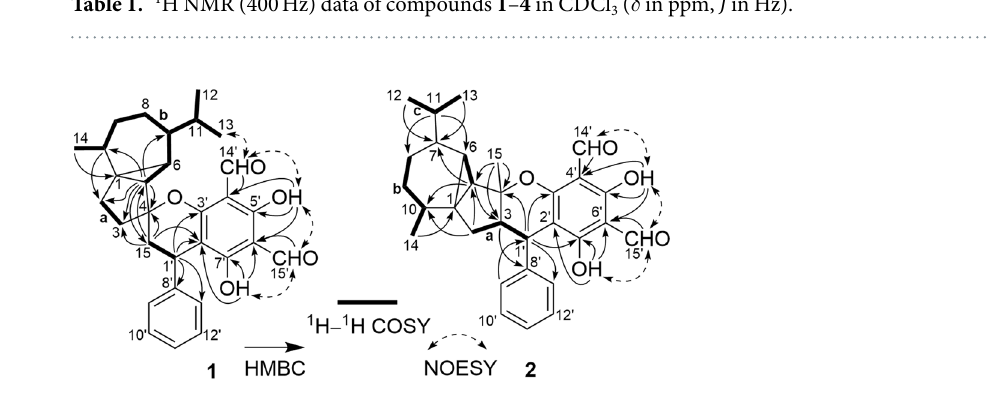
were replaced by a oxygenated methine ( δ C 85.5, C-2) and a tetra-subsitituted double bond ( δ C 138.2 and 136.0, C-1 and C-10) in 3 . This indicated that the oxygen bridge started from C-1 in 16 was migrated to C-2 with the formation of Δ 1(10) in 3 , which was further confirmed by the HMBC correlations (Fig. 6) from H 3 -14 to C-1, C-9, and C-10 and from H-2 to C-3 ′ , C-1, and C-10. The relative configuration of 3 was assigned by the NOE analysis (Fig. 7). The NOE correlations of H-3b/H-2, H-6, and H 3 -15, H-3a/H-2, H 3 -15, and H-13 ′ (9 ′ ), H 3 -12/H-6 and H-7, and H 3 -15/H-9 ′ (13 ′ ) indicated that H-2, H-6, H-7, CH 3 -12, CH 3 -15, the phenyl group, and the C-2–C- 3–C-4 bridge were cofacial and were arbitrarily assigned β -orientations. Thus, the α -orientation of H-5, H 3 -13, and H-1 ′ was deduced by the NOE correlations of H-5/H 3 -13 and H-1 ′ . The absolute configuration of 3 was estab- lished as 2 R , 4 S , 5 R , 6 R , 7 R , 1 ′ R by comparison of its experimental ECD spectrum with those of the calculated iso- mers (Fig. 8). Compound 3 represents the first example of Psidium meroterpenoid coupling via an oxepane ring. Psiguajadial D ( 4 ) possessed the molecular formula C 30 H 34 O 5 as determined by its HR-ESI-MS and 1D NMR data. The 1 H and 13 C NMR data of 4 bore a high resemblance to those of guapsidial A ( 17 ) 11 , with the major differences occurring at C-3 ′ , C-7 ′ , and C-8 ′ of the benzoyl-phloroglucinol moiety ( Δ δ C = 2.3, 1.9, and 1.6 ppm, respectively), indicating that 4 possessed a different substitution pattern at the phloroglucinol unit. The locations of 5 ′ -OH, 7 ′ -OH, and 15 ′ -CHO were assigned by HMBC correlations from the corresponding protons to C-5 ′ , C-7 ′ , and C-6 ′ , respectively (Fig. 6). Consequently, the benzoyl group was located at the only remaining position on the phloroglucinol ring (C-2 ′ ). This was further supported by the NOE cross-peaks of H-15 ′ /5 ′ -OH and 7 ′ -OH